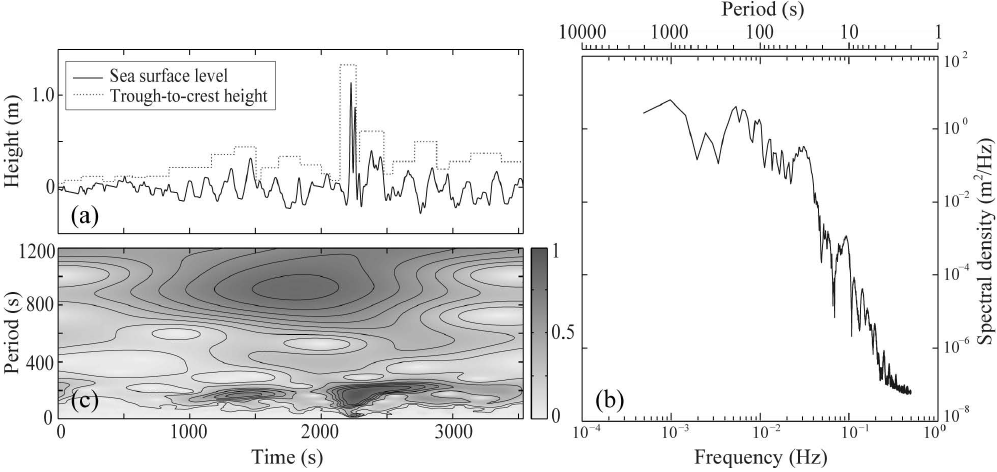
Fig. 6. (a) the detrended time-series of the vertical sea-level oscillations in Fig. 4d and trough-to-crest height of the tsunami-like waves com- puted through the zero up-crossing method, (b) energy spectrum of the detrended time-series in (a), (c) wavelet energy spectrum normalized by the maximum energy value.